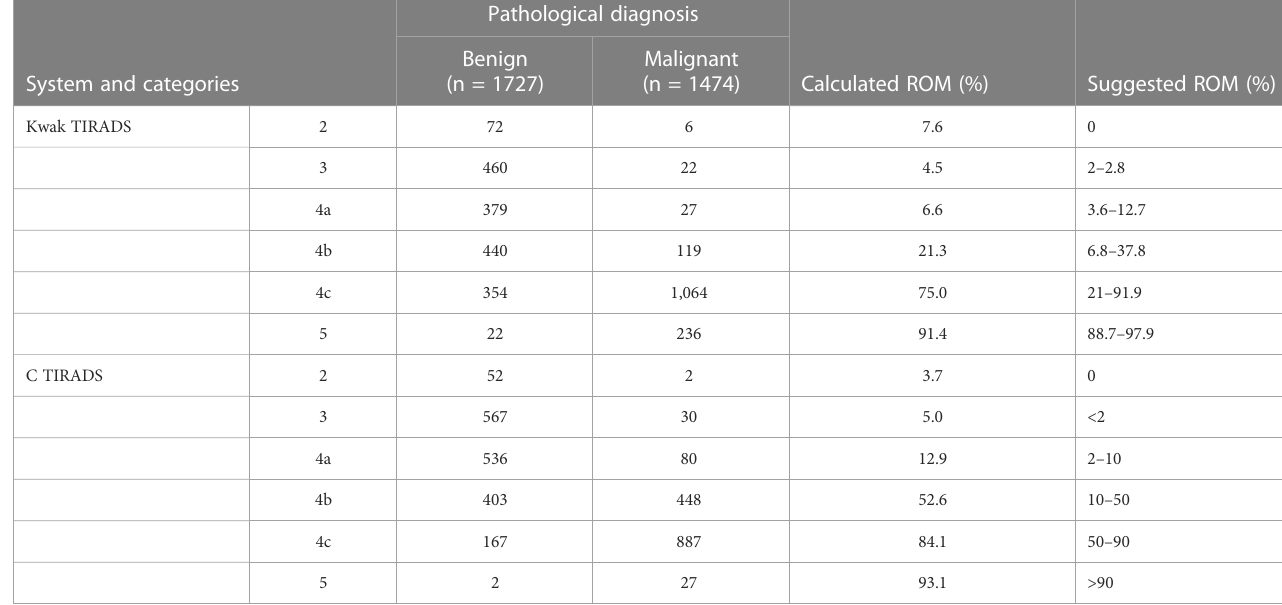
TABLE 3 Malignancy risks according to categories in the Kwak and C TIRADS. System and categories